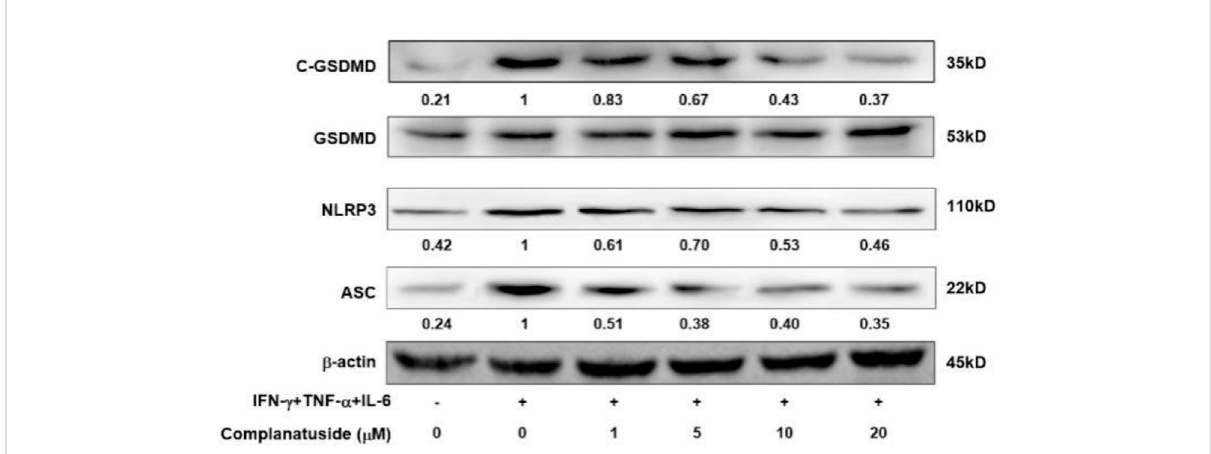
FIGURE 6 Effects of complanatusideon thelevels of NLRP3, ASC,and cleavedGSDMD inHaCaT cells treated with thecytokinecombination. HaCaTcells were treated with various concentrations of complanatuside with or without co-treatment with the cytokine combination for 24 h. The levels of NLRP3, ASC, and cleaved GSDMD were determined by Western blot